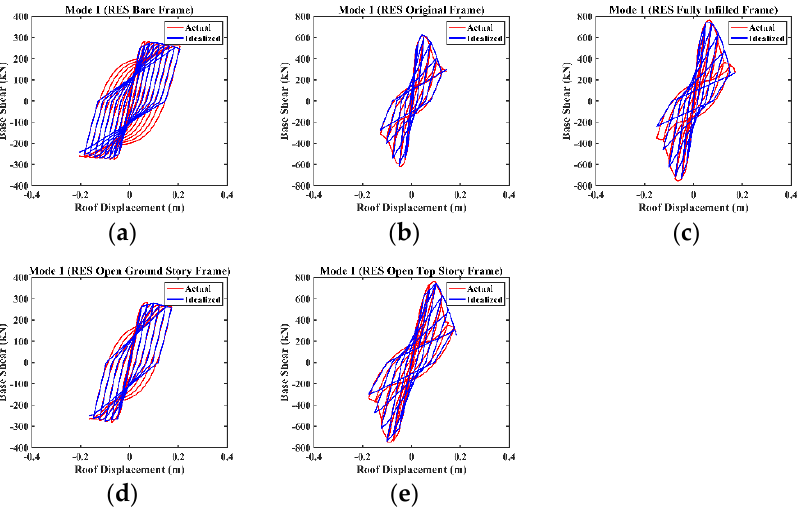
Figure 16. Actual cyclic pushover curves versus idealized nonlinear SDOF system curves of building RES: ( a ) bare frame; ( b ) original frame; ( c ) fully infilled frame; ( d ) open ground-story frame; ( e ) open top-story frame. Table 6. Properties of the first modal inelastic SDOF systems of RES.